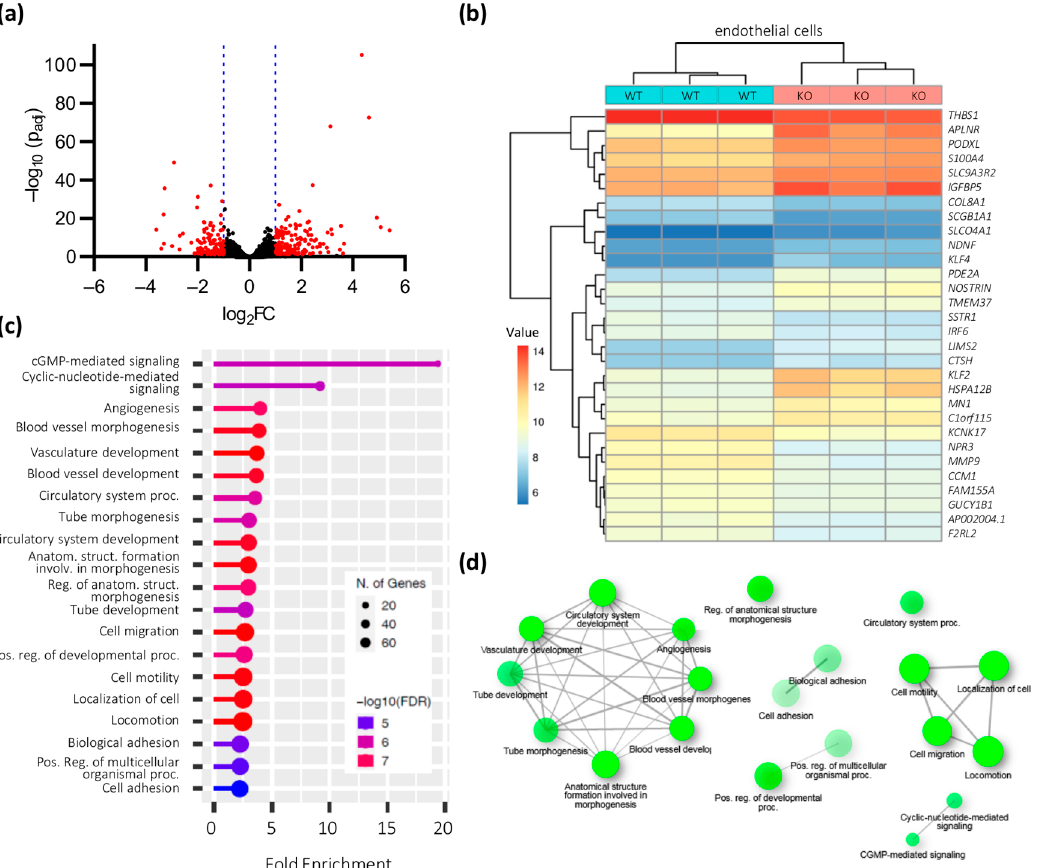
Figure 3. Gene expression differences in CCM1 − / − iPSC-derived ECs. ( a ) Volcano plot of up- or downregulated genes in CCM1 − / − iPSC-derived ECs. The log 2 fold change (log 2 FC) of the normalized mean hit counts is plotted against the negative log 10 adjusted p value ( − log 10 (p adj )). Differentially expressed genes (=p adj < 0.05 and |log 2 FC| > 1) are marked in red; ( b ) heatmap of differentially expressed genes in CCM1 − / − iPSC-derived ECs. Shown are regularized log transformed read counts (= value) for CCM1 − / − (KO) and CCM1 +/+ (WT) iPSC-derived ECs; ( c ) GO biological process enrichment analysis for differentially expressed genes in CCM1 − / − iPSC-derived ECs. To avoid a systemic bias, CCM1 was excluded from the enrichment analysis. FDR = false discovery rate; ( d ) enriched GO terms are visualized as a network. The size of the network nodes reflects the number of genes. Lines connect related terms. The thickness of the lines reflects the percent of overlapping genes. The lollipop chart ( c ) and the network ( d ) were created with ShinyGO 0.76 [22]. n = 3 per